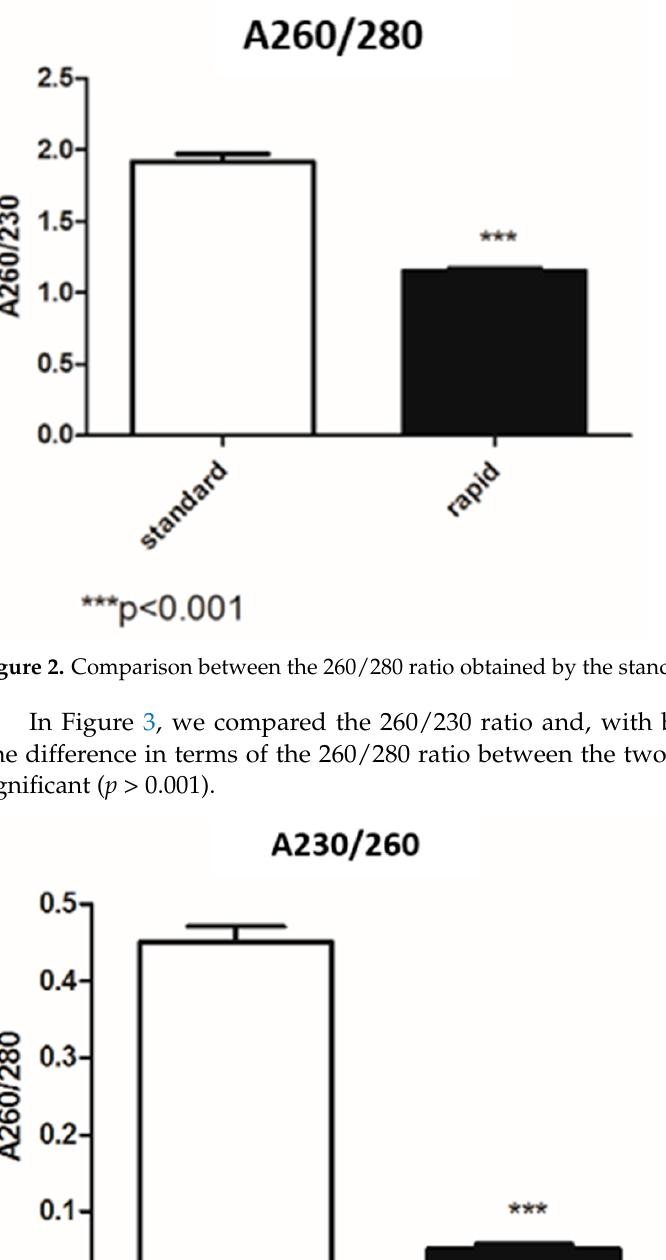
Figure 3. Comparison between the 230/260 ratio obtained by the standard and rapid extraction kits.